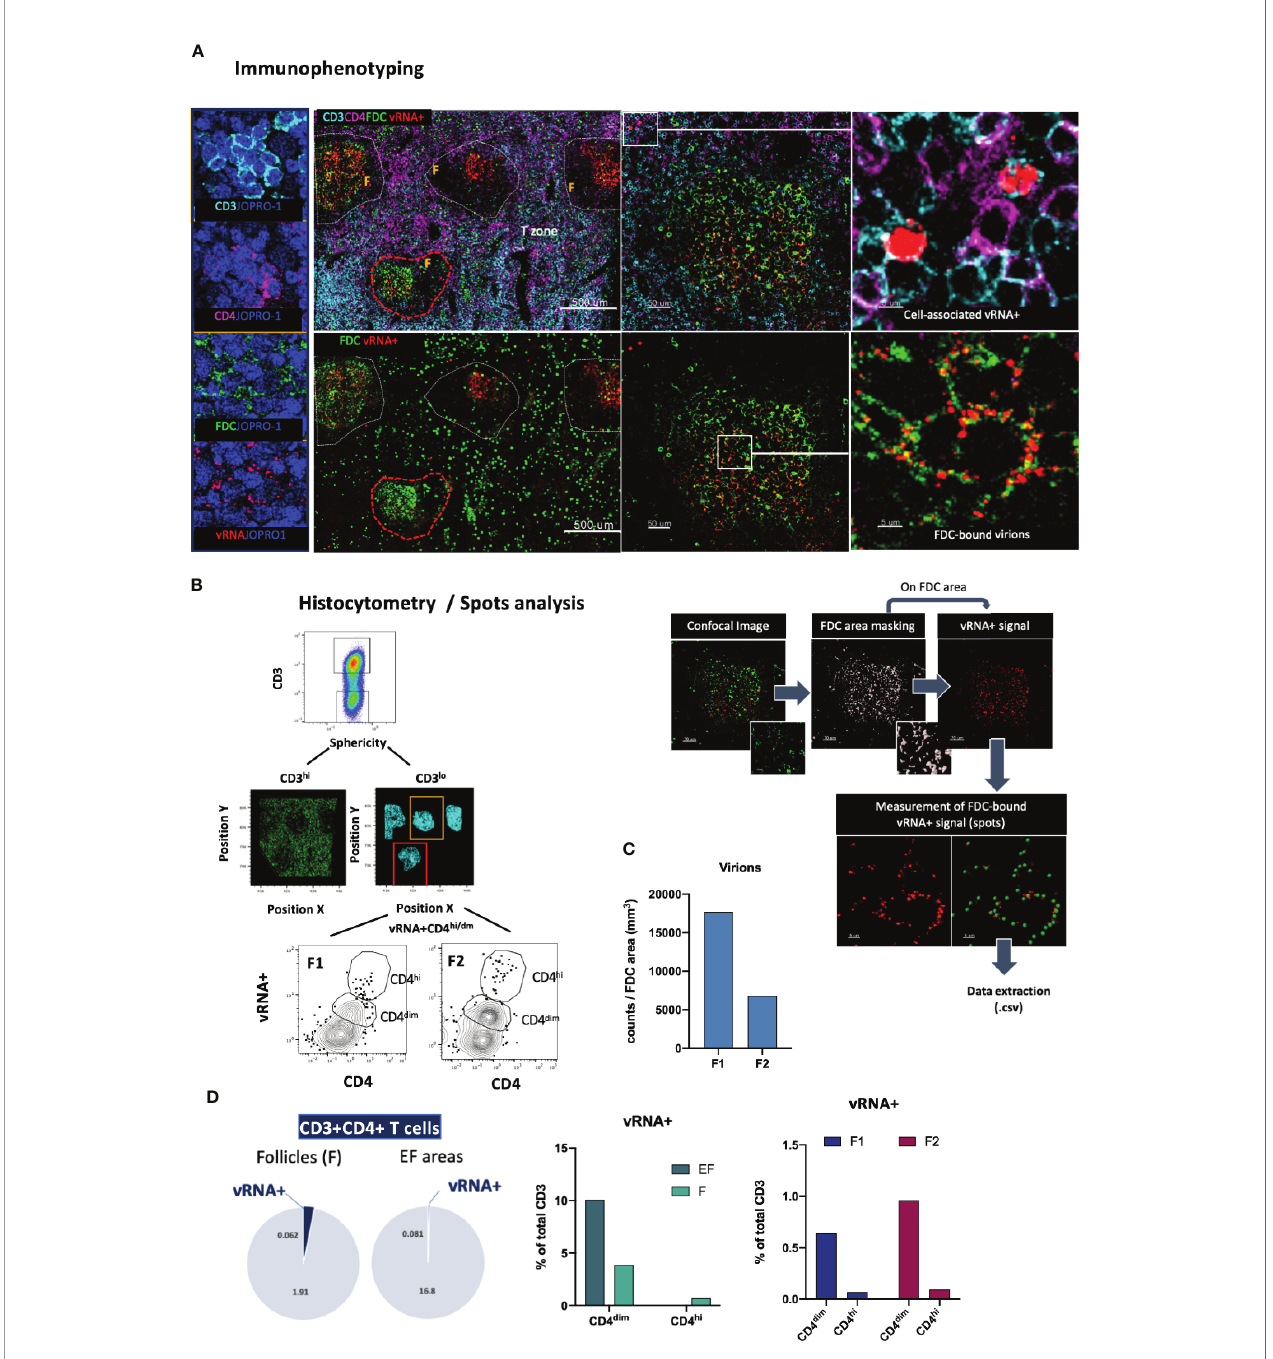
FIGURE 8 | Immuno fl uorescent in situ hybridization (IF-FISH) for the visualization of actively transcribed HIV (vRNA+) in lymph nodes. (A) Representative images showing staining for CD3 (cyan), CD4 (magenta), FDC (green) and HIV RNA (red) and the nuclear stain JOPRO-1 (blue) in a lymph node section from a viremic HIV+ individual. Images shown (50um,5um) are sequential close ups of the red dotted enclosures and white enclosures respectively and depict the staining seen in a B- cell follicle and distinct patterns of associated vRNA+ staining (cell-associated vs FDC-bound virions). (B) Gating strategy used for the quanti fi cation of vRNA+ signal in CD3+ CD4 hi/dim T cells in two well de fi ned B-cell follicles using HistoCytometry (left) and graphic panel summarizing the approach used to quantitate FDC-bound virions in lymphoid tissues (right). (C) Bar graph showing the FDC-associated virion burden in the two follicles examined as measured by histocytometry and surface spot analysis on Imaris. (D) Bar graphs showing the distribution of the vRNA+ signal in EF and F spaces as well as the relative distribution of the signal in CD4 hi vs CD4 dim cells and pie charts depicting the proportions of CD3+CD4+ T cells that are vRNA+/vRNA- in F and EF spaces as measured by HistoCytometry. The percentages given represent the frequency of each respective CD4 T cell population (EF vRNA+ or vRNA-/F vRNA+ or vRNA-) as a percentage of total cells d) and FDC-associated virion burden as Images were acquired at 40x (NA 1.3) with 1% magni fi